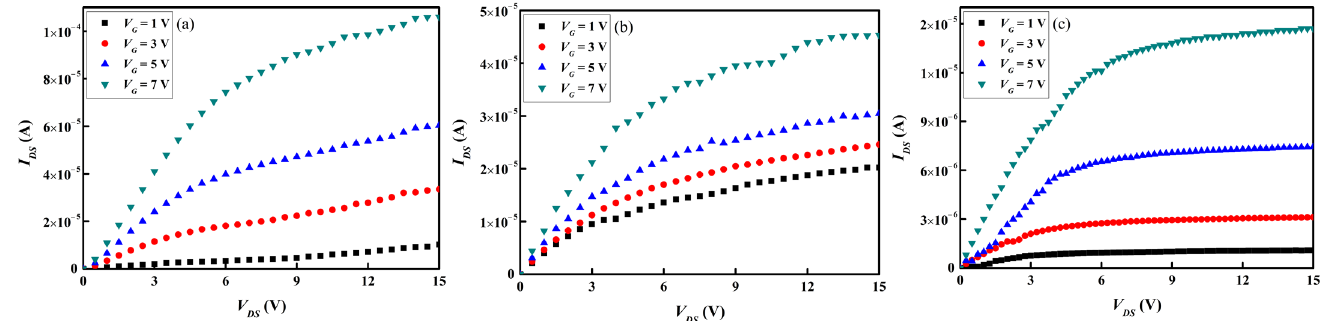
Figure 14. Output characteristics of TFT devices containing ( a ) a -InGaZn 2 O 5 , ( b ) a -InGaZnO 4 , and ( c ) a -InGa 2 ZnO 5.5 active channel layers subjected to post-annealing at 300 °C for 1 h in an ambient atmosphere. Table 6. Transfer characteristics of the three types of a -IGZO TFT samples subjected to post-anneal- ing at 300 °C for 1 h in an ambient atmosphere.